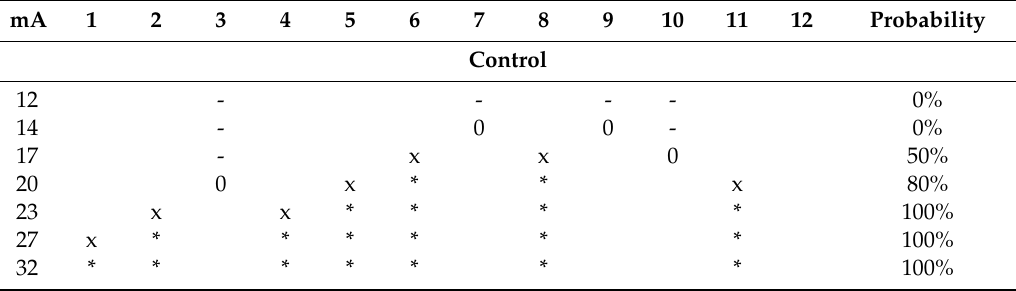
Table A1. Results of the MEST test in three groups of